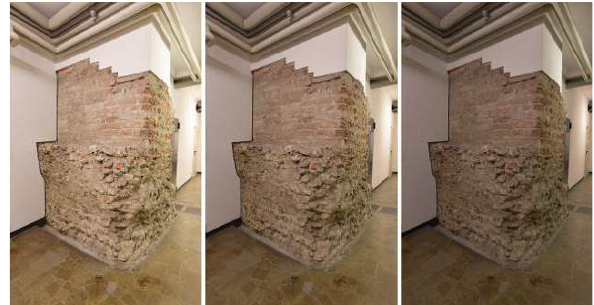
Figure 6. Example of overexposure and underexposure of the same shot, in the middle the image with calibrated exposure (0.0) During the shoots, the lens was kept at the focal length of about 20mm with an aperture of the diaphragm between F8 and F9 to ensure homogeneity between the images.